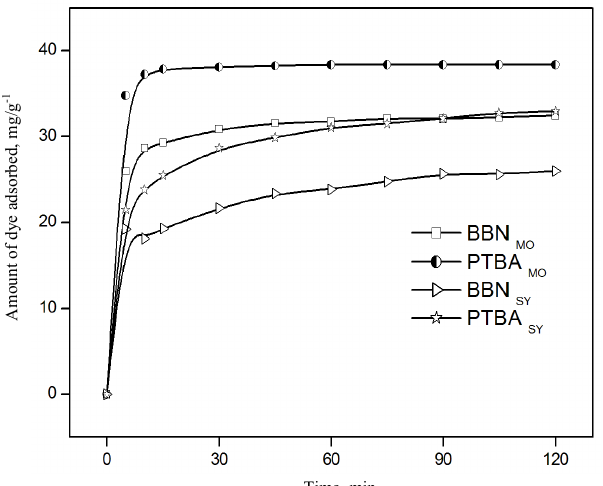
Figure 8. Evaluation of adsorptive performance of BBN and PTBA in removing MO and SY dyes from an aqueous